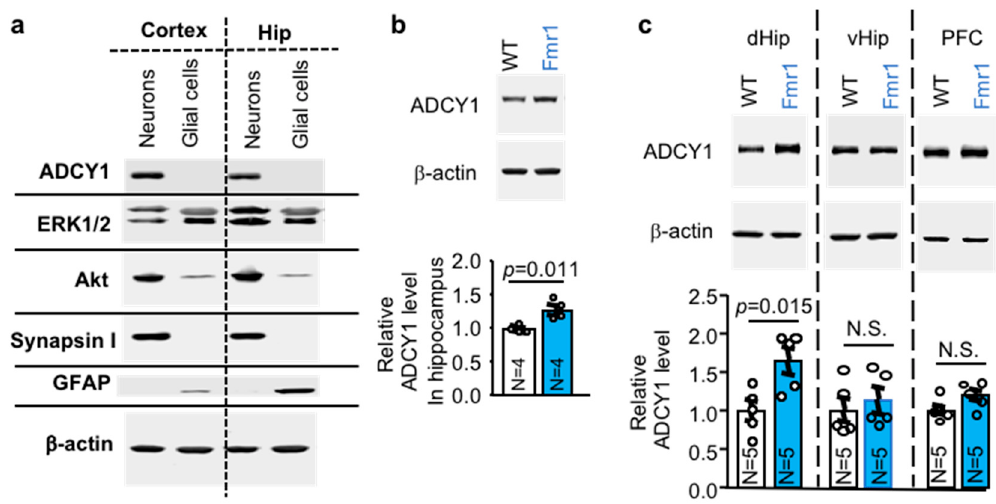
Figure 1. ADCY1 expression in wild type and Fmr1 knockout samples. ( a ). ADCY1 is expressed in neurons but not in glial cells. Primary cultures of neuron or glial cell were obtained from new born cortex and hippocampus. Cells were harvested on DIV (days in vitro) 14. Expression of ADCY1, ERK1/2, Akt, synapsin I (a neuronal marker protein), GFAP (a glial cell marker protein), and β -actin in neuronal or glial preparations were determined by Western blot analysis. ( b ). ADCY1 protein expression is elevated in the hippocampus of adult Fmr1 KO mice. Hippocampal tissues were collected from 3-month old wild type (WT) and Fmr1 KO ( Fmr1 ) mice. The expression of ADCY1 was determined by Western blot and normalized to the level of β -actin. ( c ). ADCY1 expression in the dorsal hippocampus (dHip), ventral hippocampus (vHip), and prefrontal cortex (PFC) of 3-month WT and Fmr1 KO mice. The level of ADCY1 was normalized with β -actin. Data are presented as average ± SEM. Quantification of ADCY1 level is based on data collected from 4 (in ( b )) and 5 (in ( c )) independent biological samples of WT and Fmr1 KO mice. The p values were determined by Student’s t -test. N.S.: not significant.